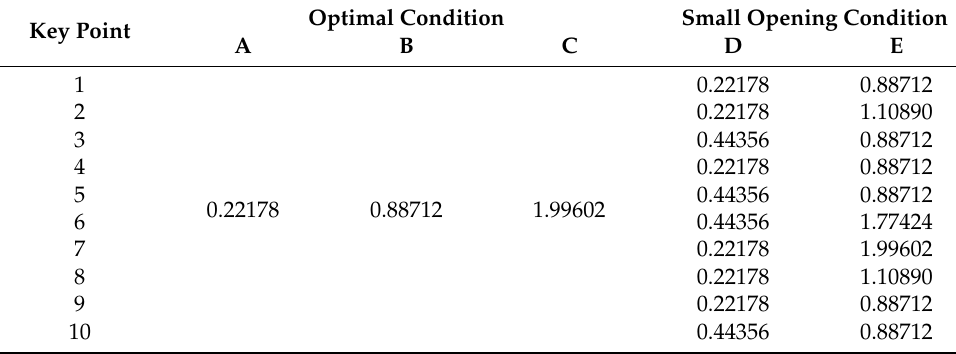
Figure 16. Draft tube. Table 3. Frequency of key point